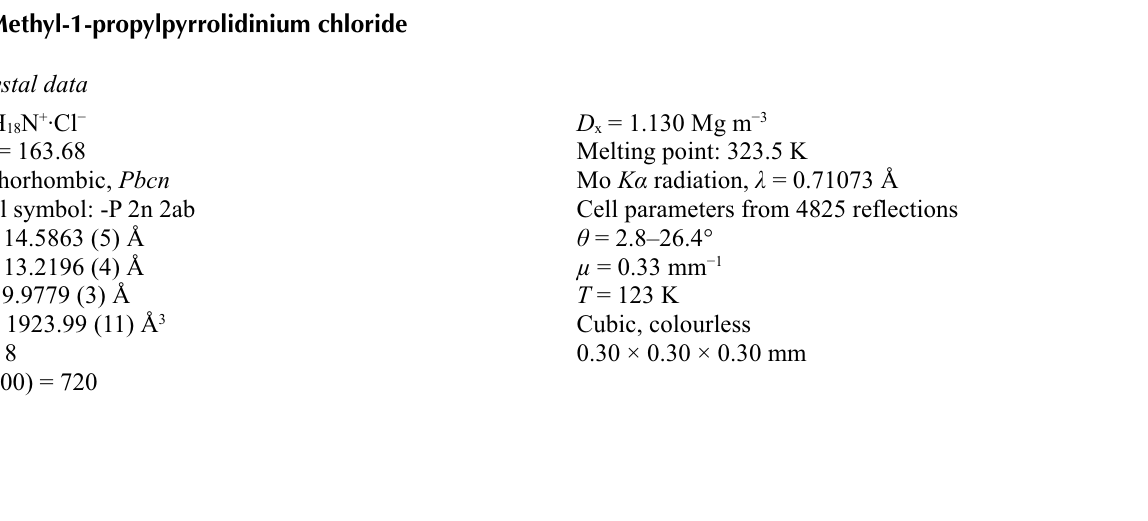
Extended packing diagram of the unit-cell contents of (I) as viewed down the b axis. 1-Methyl-1-propylpyrrolidinium